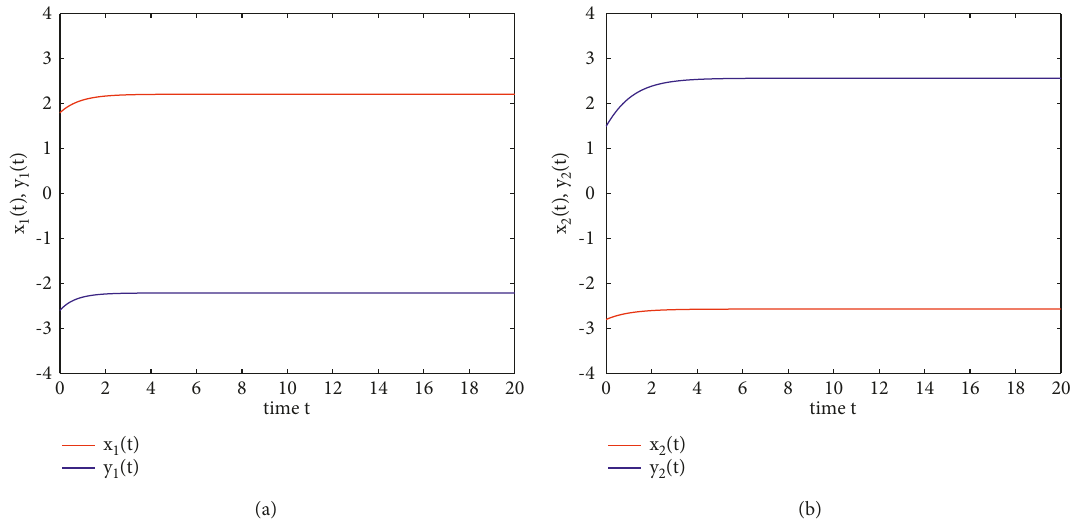
( t ) and y ( t ) for drive-response system without controller; (b) trajectories of x 1 1